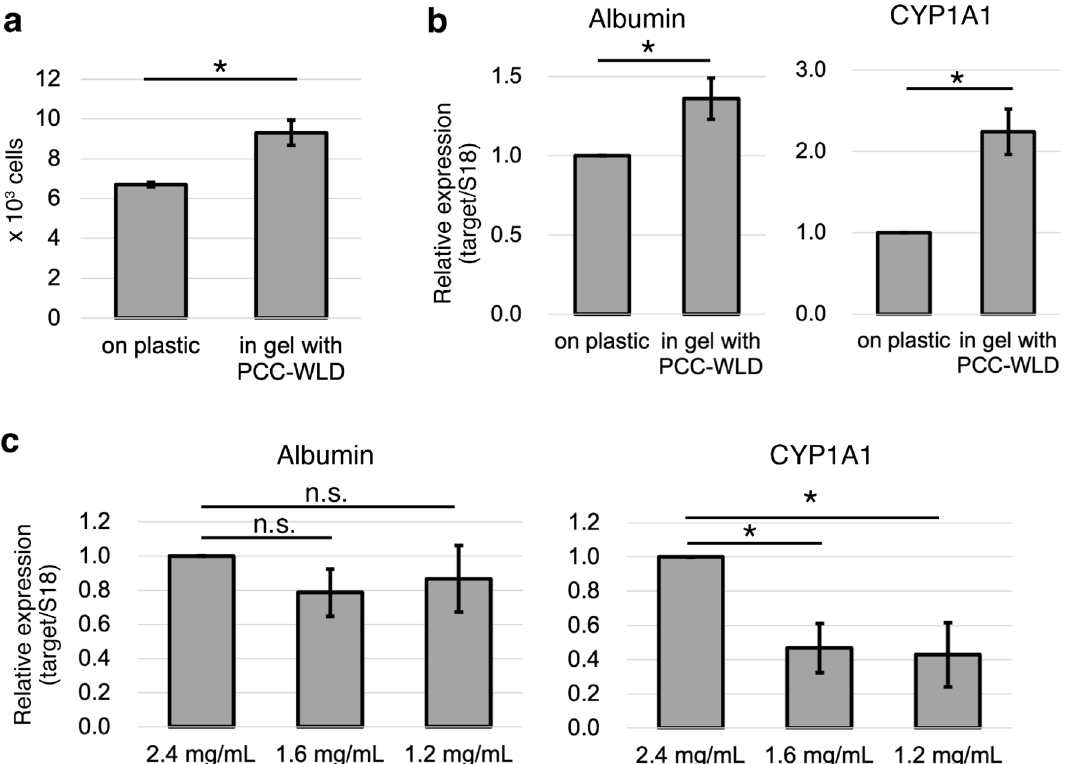
Figure 5. Cell proliferation and gene expression related to liver function were improved with PCC-WLD. ( a , b ) Cells were cultured on a plastic dish (static condition) or in 200 μL of 2.4 mg/ml collagen gel (PCC-WLD with syringe) for 3 days. ( a ) Proliferation assay. n = 3 independent experiments. Mean ± S.E. *p < 0.05 by Student’s t test. ( b ) Quantitative real-time PCR of albumin and CYP1A1. n = 3 independent experiments. Mean ± S.E. *p < 0.01 based on the confidence interval (CI) test. ( c ) Quantitative real-time PCR of albumin and CYP1A1 in the cells cultured in 200 μL of gels with different concentrations of collagen. n = at least 4 independent experiments Mean ± S.E. n.s. no significance. *p < 0.01 based on the CI test with Bonferroni